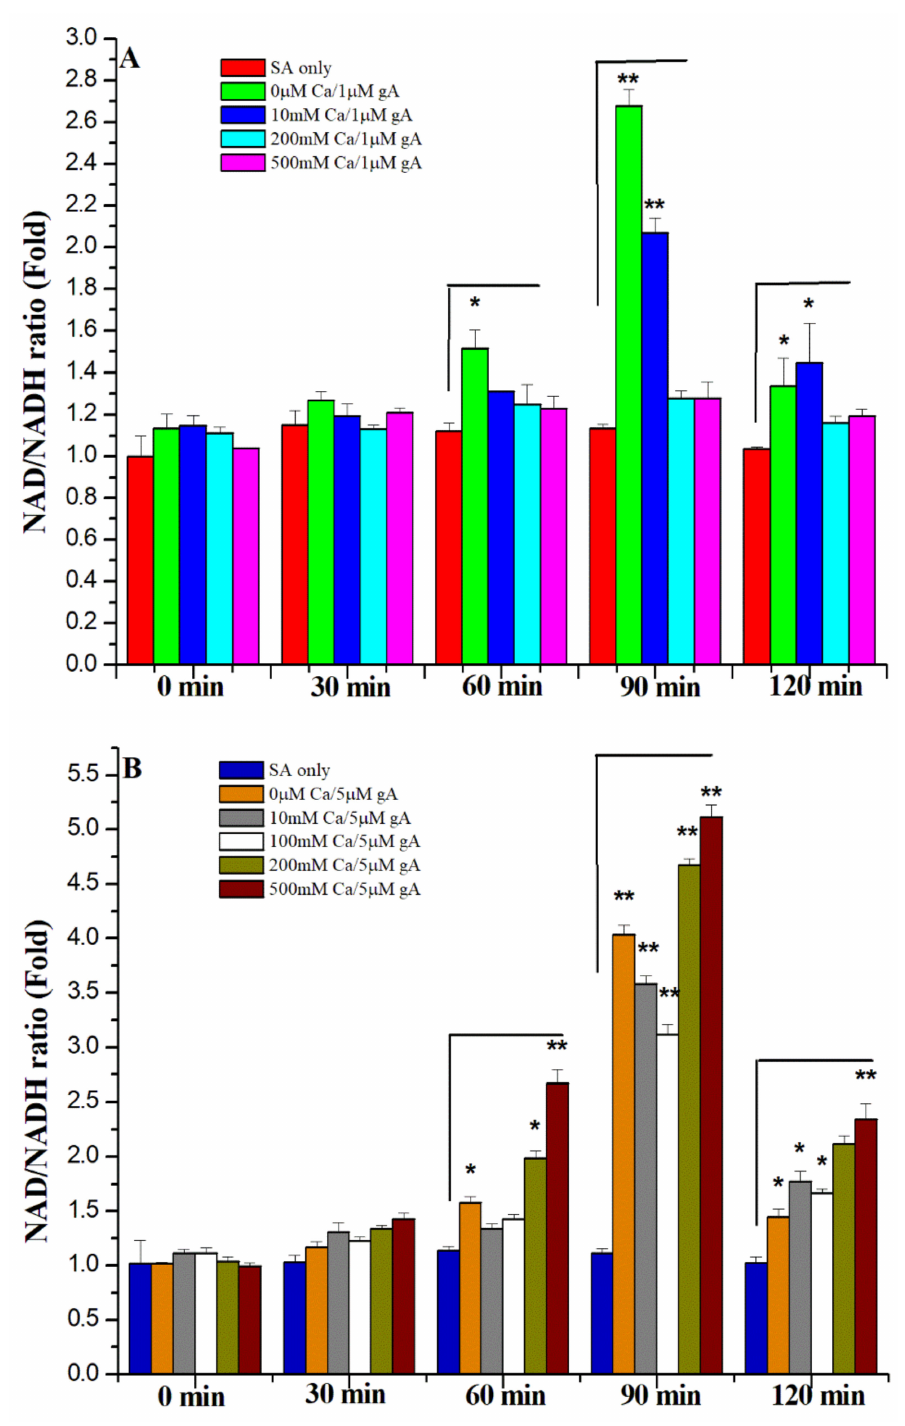
Figure 5. The NAD + /NADH ratios for S. aureus treated with ( A ) 1 and ( B ) 5 µ M gramicidin A and 10, 100, 200, and 500 mM Ca 2+ ions at 0, 30, 60, 90, and 120 min, respectively. ( n = 9, ** p < 0.001, * p <